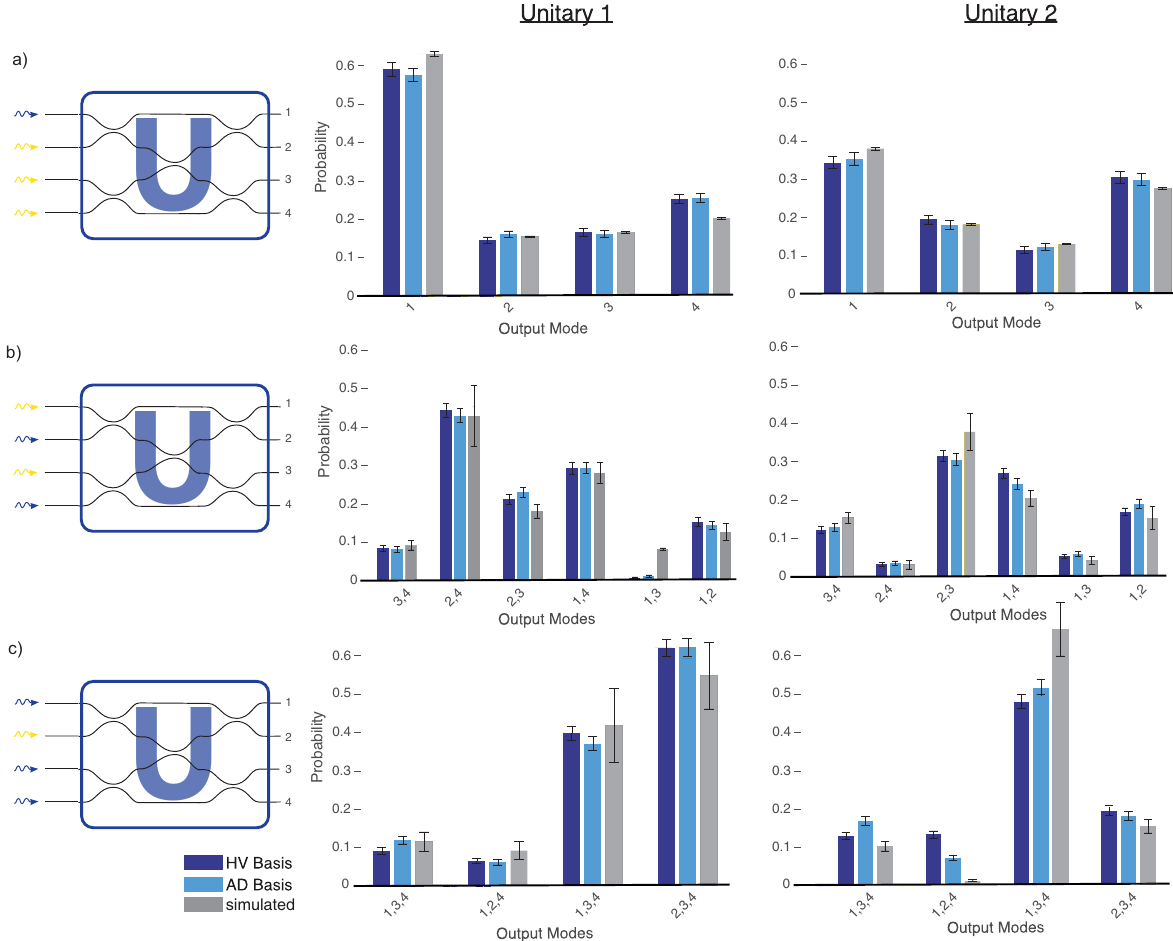
Fig. 3 Results of the encrypted quantum walk. We use two different unitaries to execute multiple encrypted quantum walk computations. a Unitary transformation of a single-photon state, b quantum walk with two photons, and c quantum walk with three photons. Blue photons represent data photons, whereas yellow photons are ancilla photons used to mask the computation that is performed (see Fig. 1). The output probability distribution for two different unitaries is shown. In each case, the computation was performed in two mutually unbiased polarization bases (see “ Supplementary Information ” ). The fi delities (Bhattacharyya distance 18 ) between the simulated (see “ Methods ” ) and measured probabilities are a 0.99±0.02, b 0.99±0.02, and c 0.99±0.03 and demonstrate the polarization independence of the computation. More data and discussion of error analysis is provided in “ Methods ” and the “ Supplementary Information ” .